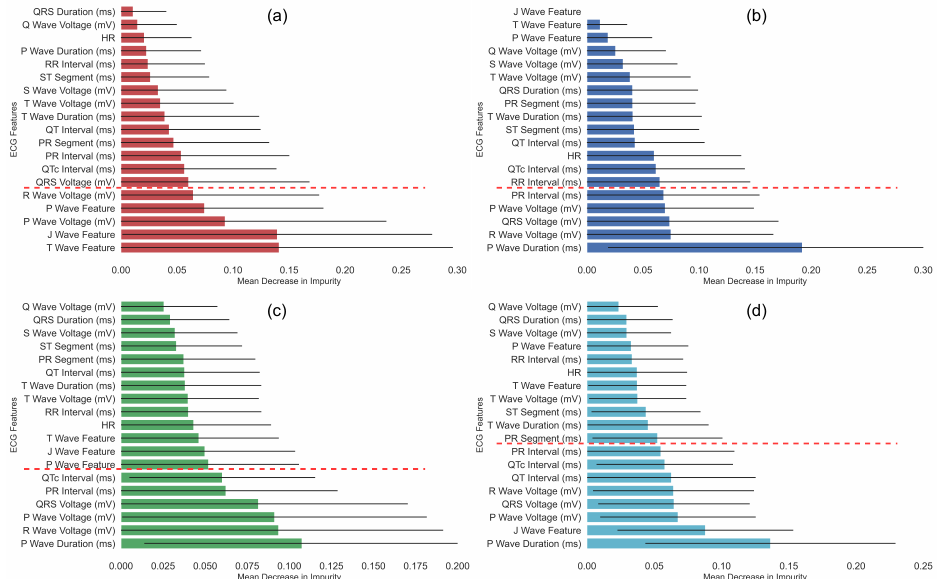
Figure 4. Analysis of ECG descriptors importance using the Mean Decrease in Impurity (MDI). ( a ) Comparison of Control 1 vs. the group with acute infection, ( b ) Control 2 vs. the group with chronic infection, ( c ) Control 1 and 2 vs. the infected groups (acute and chronic), and ( d ) Control 1 and 2 vs. the acute group vs. the chronic group (multiclass analysis). Each bar represents the mean value, the black lines the standard deviation, and the red dotted lines the threshold used to select the most relevant